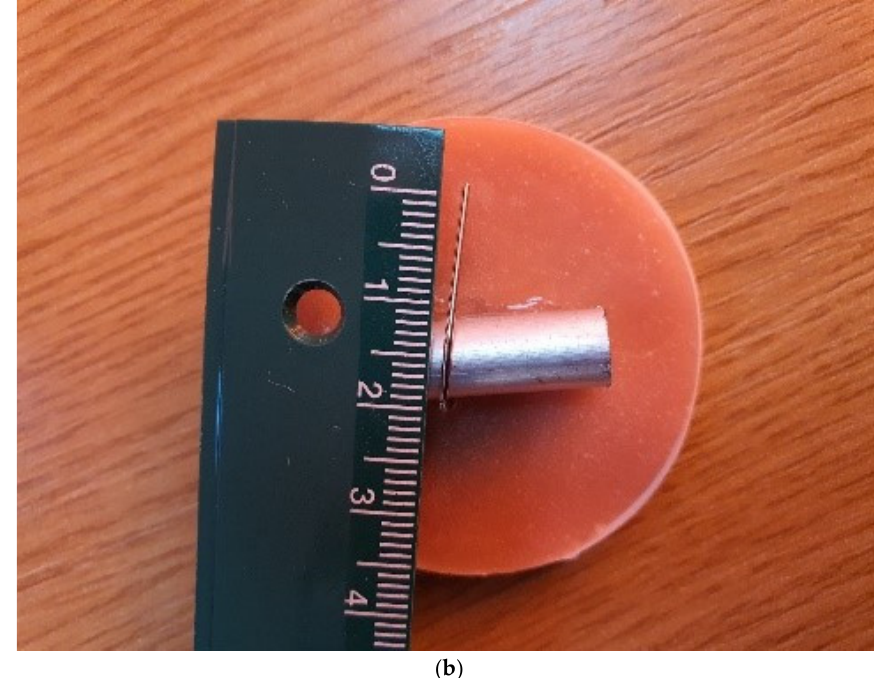
Figure 2. ( a ) Cylinders with bent springs; ( b ) wire distance measurement.